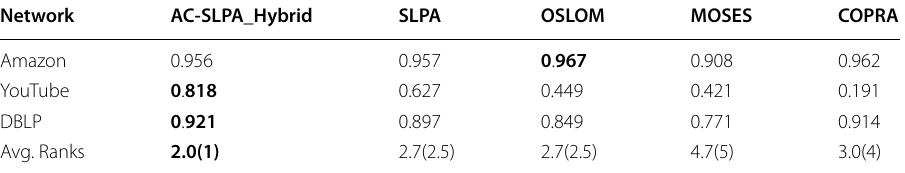
Table 20 Average NMI scores of AC-SLPA using Hybrid cleaning methods compared to other baseline methods (SLPA, OSLOM, MOSES, COPRA) on three real-world networks. Average ranks across the networks are also